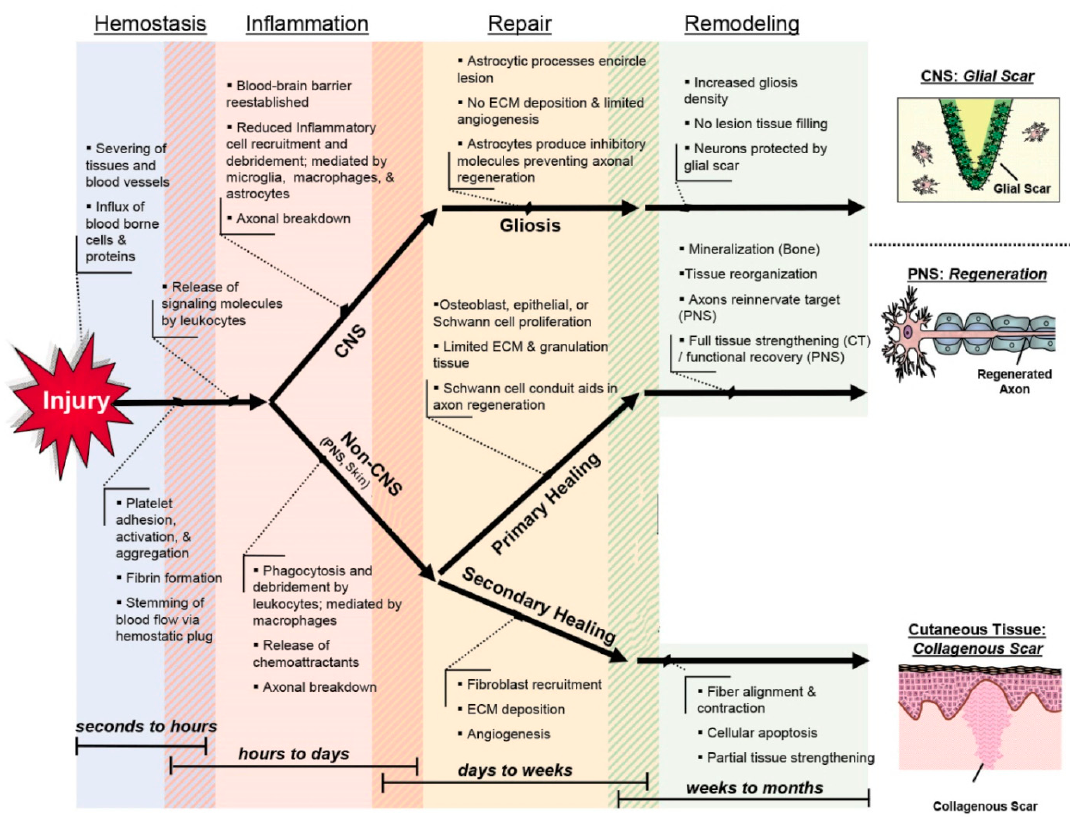
Figure 1. Schematic illustration of the wound-healing process in soft tissues post-injury. Reproduced with some modifications from [26] .